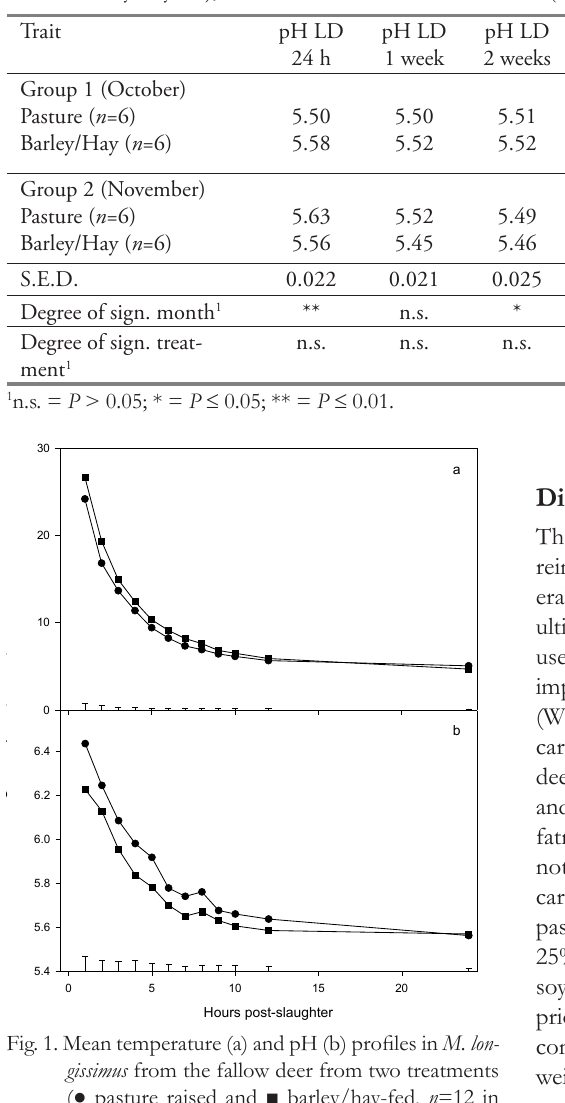
Table 2. Mean ultimate pH values (measured 24 h post slaughter) and pH values after 1, 2, and 3 weeks of refrigerated storage (+ 2 ºC) in M. longissimus (LD) for fallow deer from two feeding treatments (pasture raised and barley/hay-fed), with standard errors of the difference